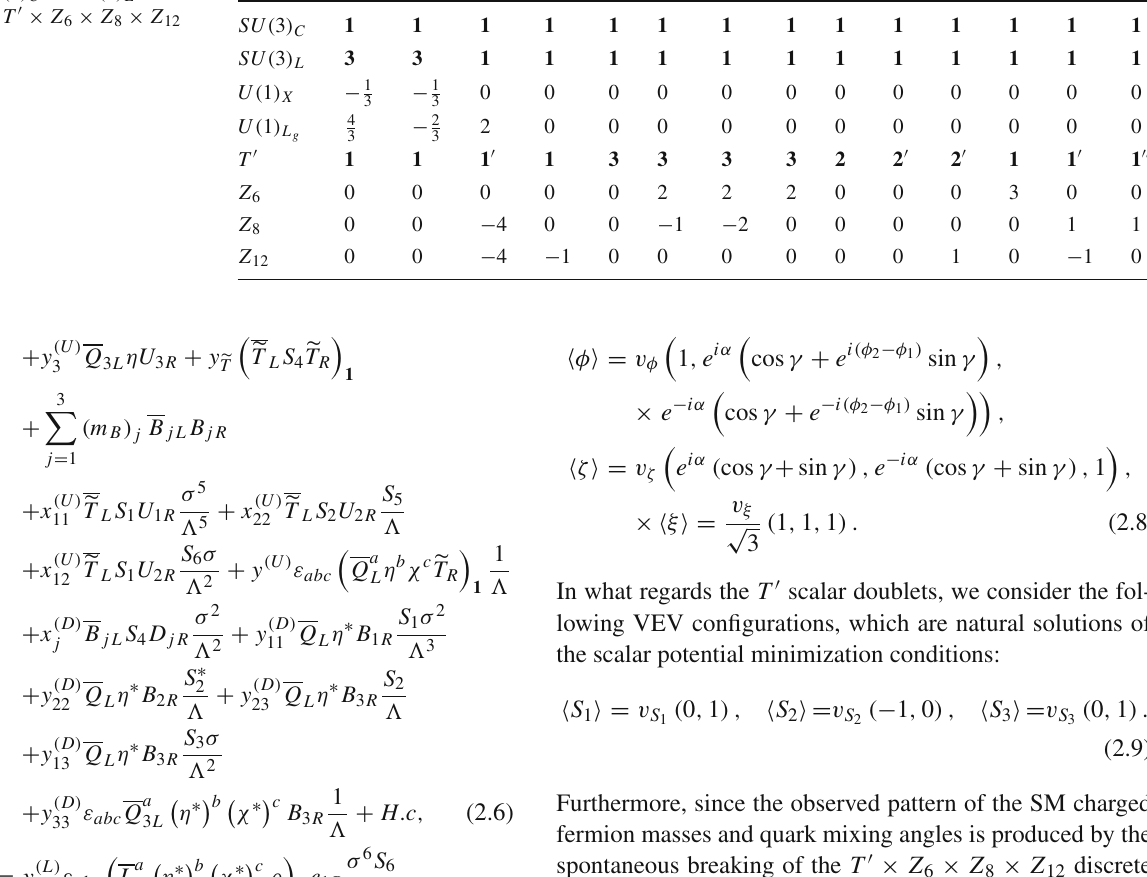
under SU ( 3 ) C × SU ( 3 ) L